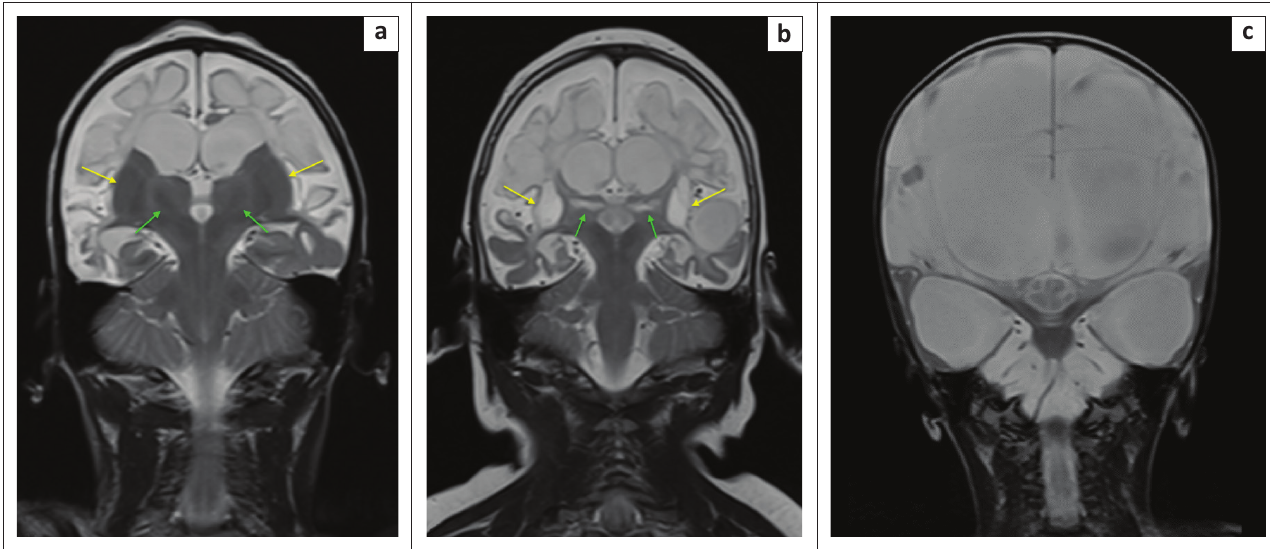
FIGURE 26: The spectrum of basal ganglia involvement in association with cystic encephalomalacia shown on coronal T2-weighted images in three children. (a) A 4- year-old female child with complete sparing of the basal ganglia, thalami and cerebellum. (b) A 2-year-old male child with necrosis of the putamen (yellow arrows) and ventral thalamus (green arrows) bilaterally. (c) A 4-year-old-male child who suffered severe total anoxia related to abruptio placentae, with birth weight of 3.35 kg and Apgar scores of 1/10 and 3/10. Note near-complete cerebral cystic encephalomalacia, atrophy of lentiform nuclei and severe thalamic